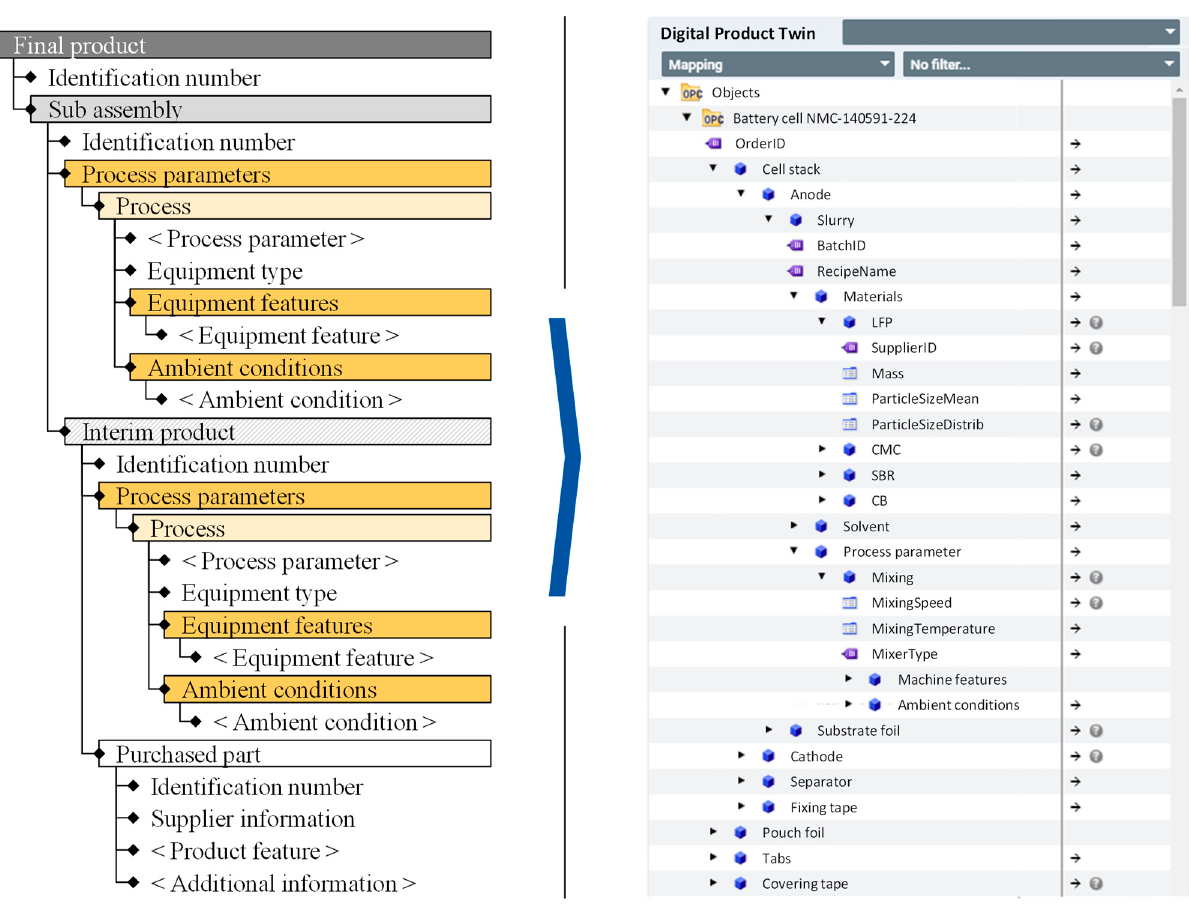
Figure 8. Section of an information model for a digital twin of a ba tt ery cell.